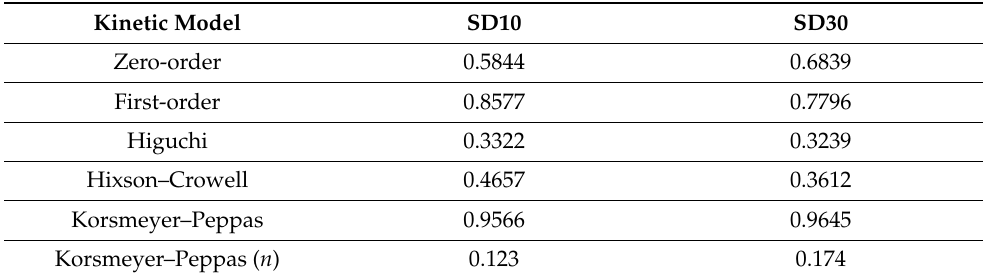
Table 3. Correlation coefficients (R 2 ) and release exponent ( n ) values obtained from different kinetic models for drug release from